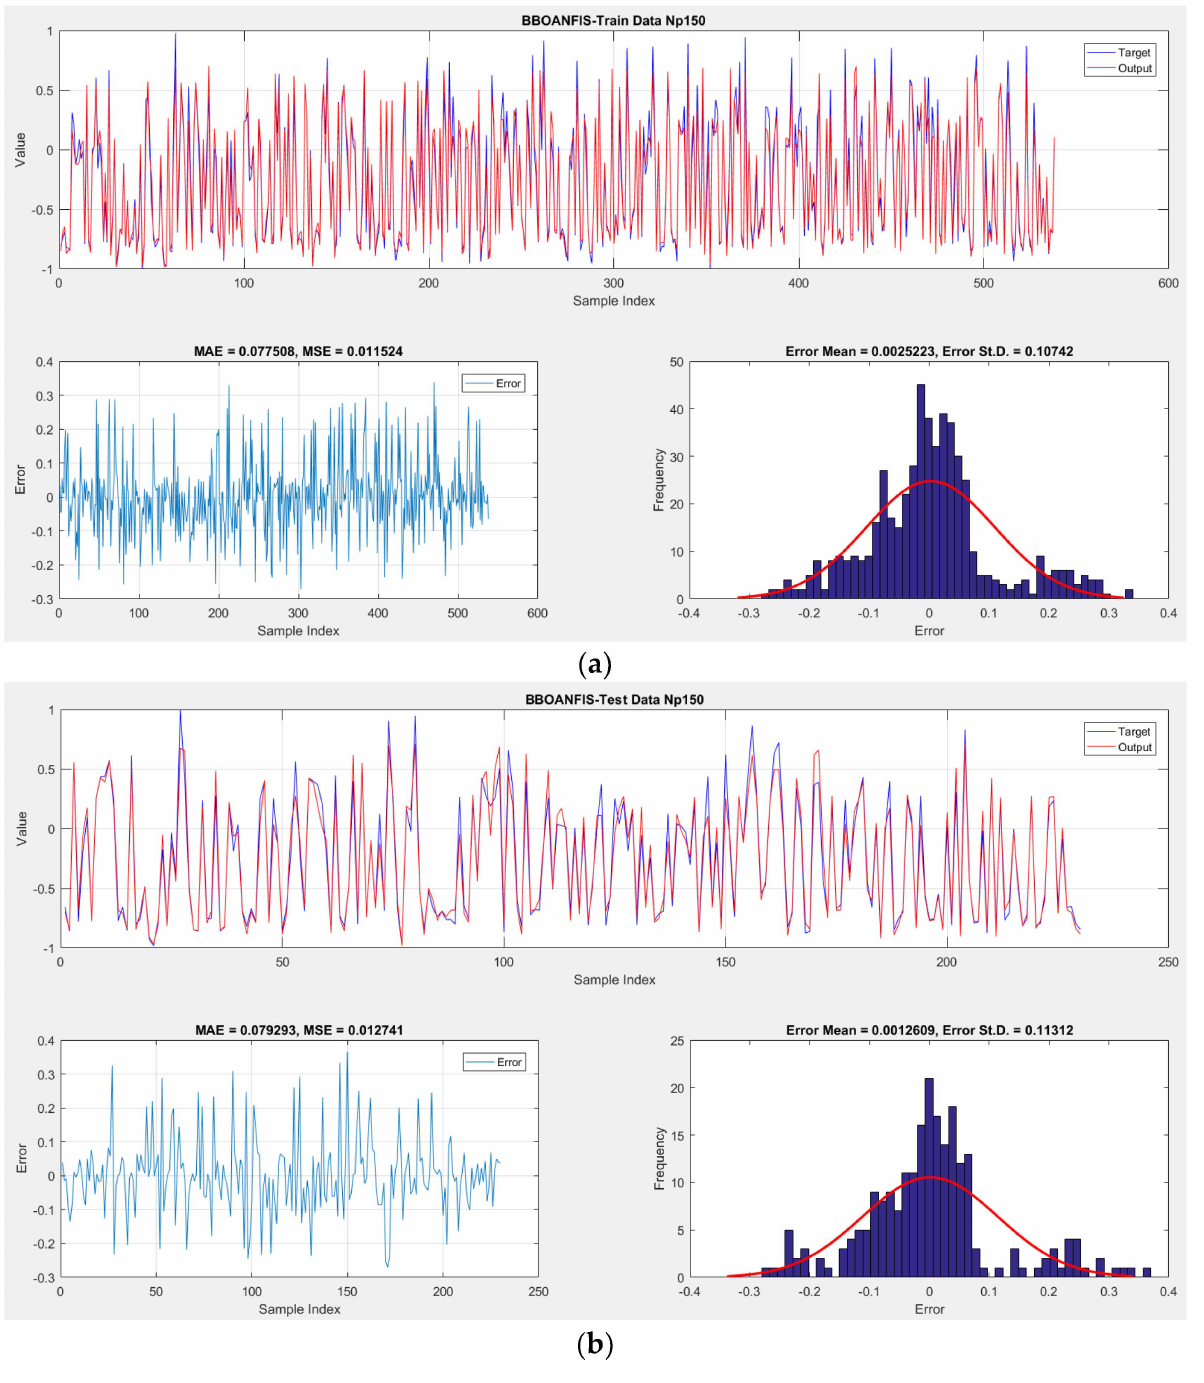
Figure 7. Frequency and minimum value of errors in BBOANFIS best-fit structure: ( a ) training dataset; ( b ) testing